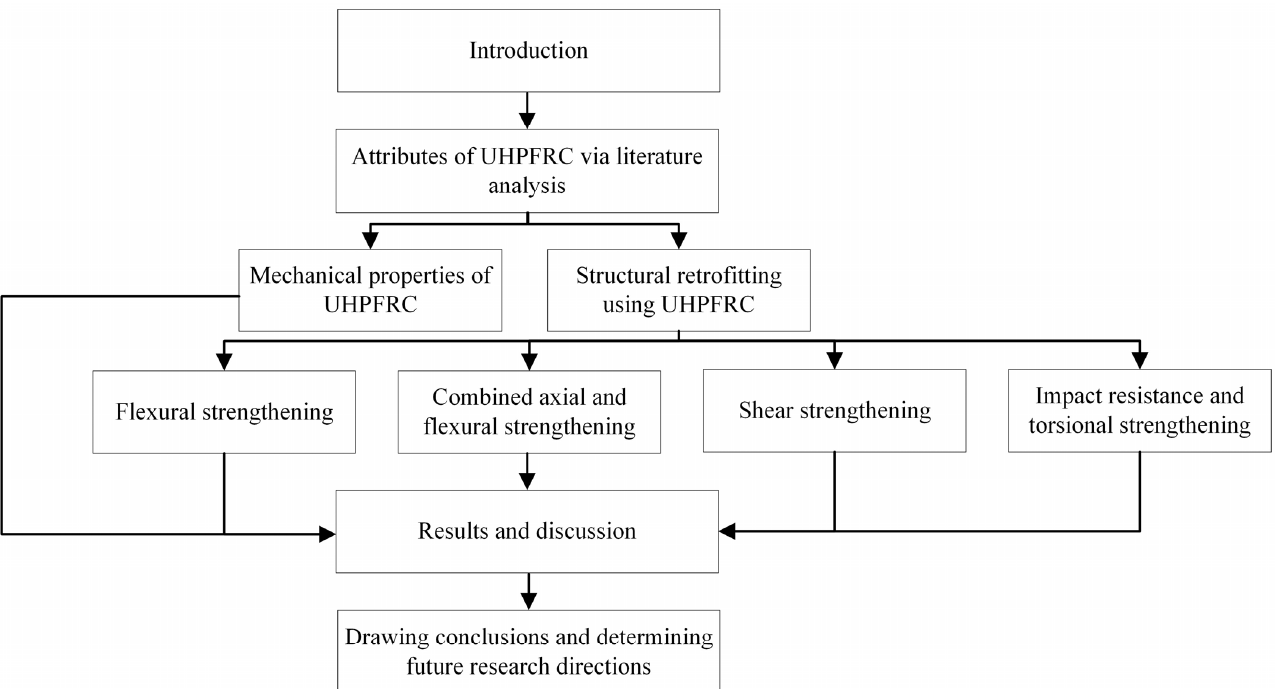
Figure 2. Flow chart of the paper organization and contents.